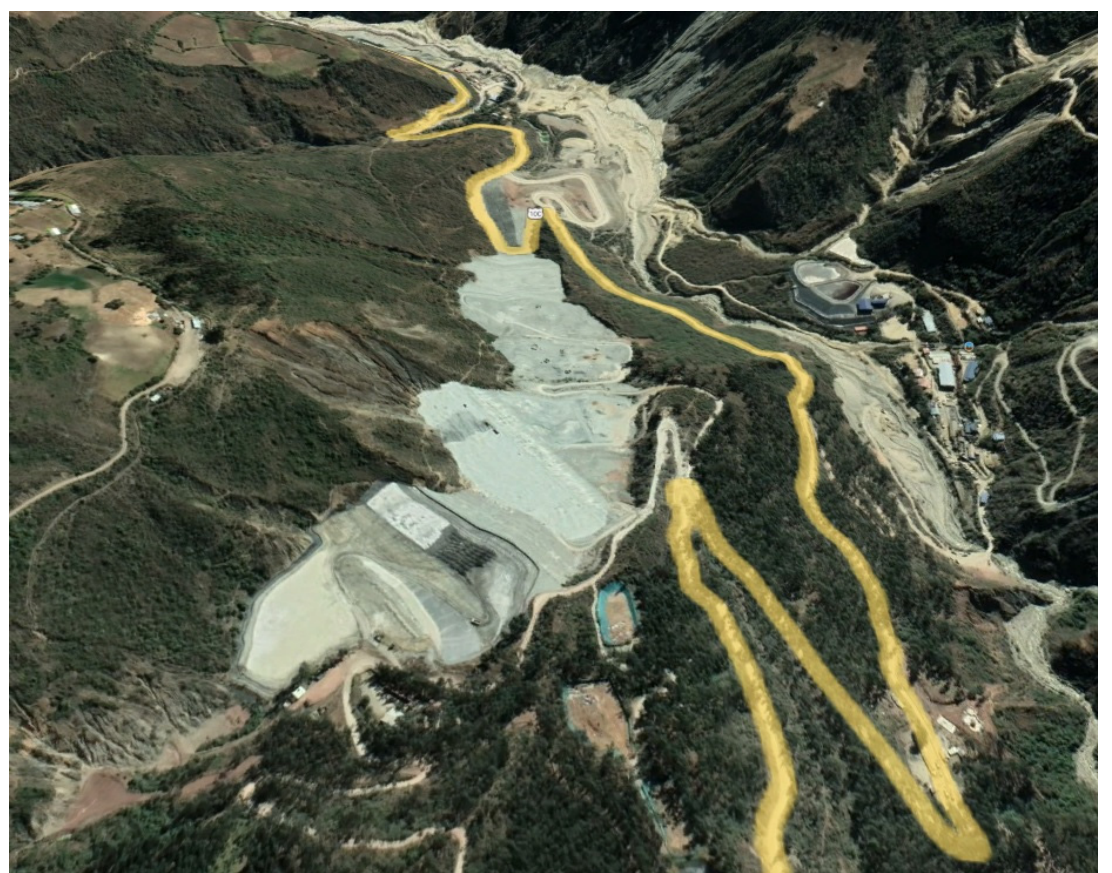
Figure 63. Curaubamba Filtered TSF—Layout [38,39].